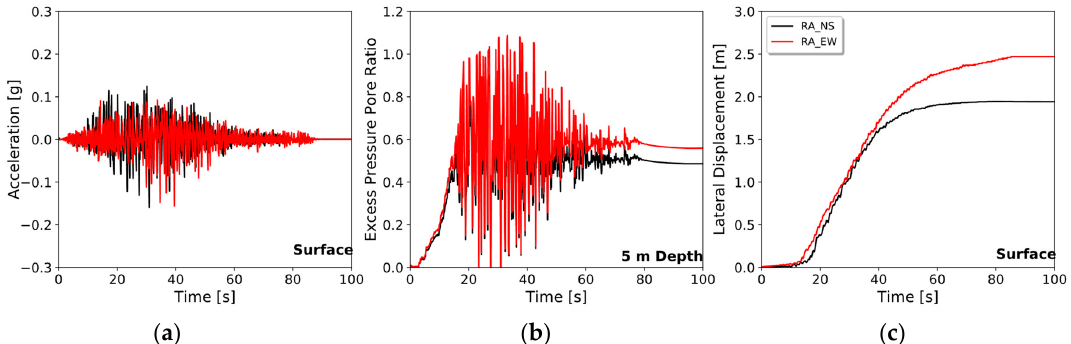
Figure 18. Numerical modeling results using both horizontal motions from the Rapel station. ( a ) horizontal acceleration at the surface, ( b ) excess pressure pore ratio at a 5 m depth, and ( c ) lateral displacement at the surface.